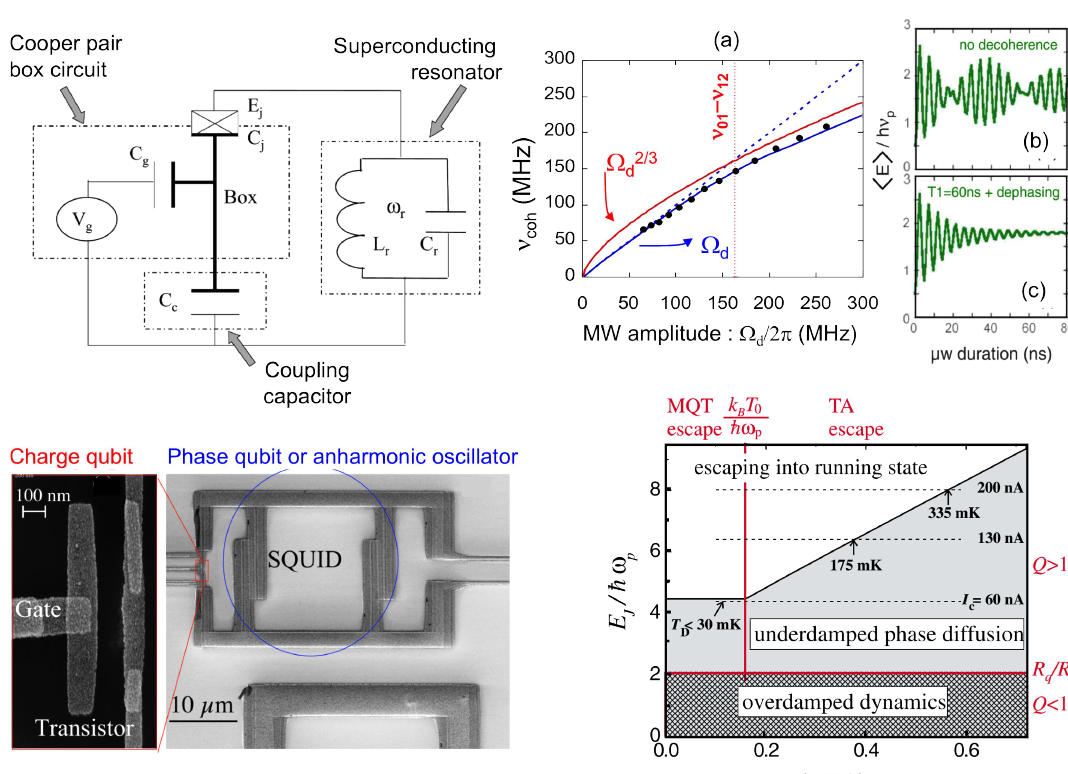
Figure 5: Top left: Quantum superconducting circuits inspired from a Rydberg atom in a high Q-cavity. The Cooper pair box corresponds to the Rydberg atom, the res- onator to the high Q cavity and the coupling is realized by a capacitor [ 55 ] . Top right: a) Rabi-like oscillation frequency as function of the microwave drive amplitude. The cross-over between the two-level limit and multilevel dynamics is indicated by the vertical dashed line. The experimental data is fitted by the quantum model (blue line) and is compared to a classical model (red line). b) and c) Average energy Rabi-like oscillations predicted by the quantum model in absence and presence of decoherence, respectively [ 63 ] . In absence of decoherence, a beating effect was pre- dicted in the Rabi-like oscillations. Bottom left: The experimental implementation of the coupled circuit. The charge qubit is realized by an asymmetric Cooper pair transistor and the resonator by a dc SQUID which is described by an anharmonic oscillator [ 59 ] . Bottom right: Phase diagram in the different dynamics of a current biased Josephson junction with low E as function of normalized temperature and J Josephson energy [ 70 ]